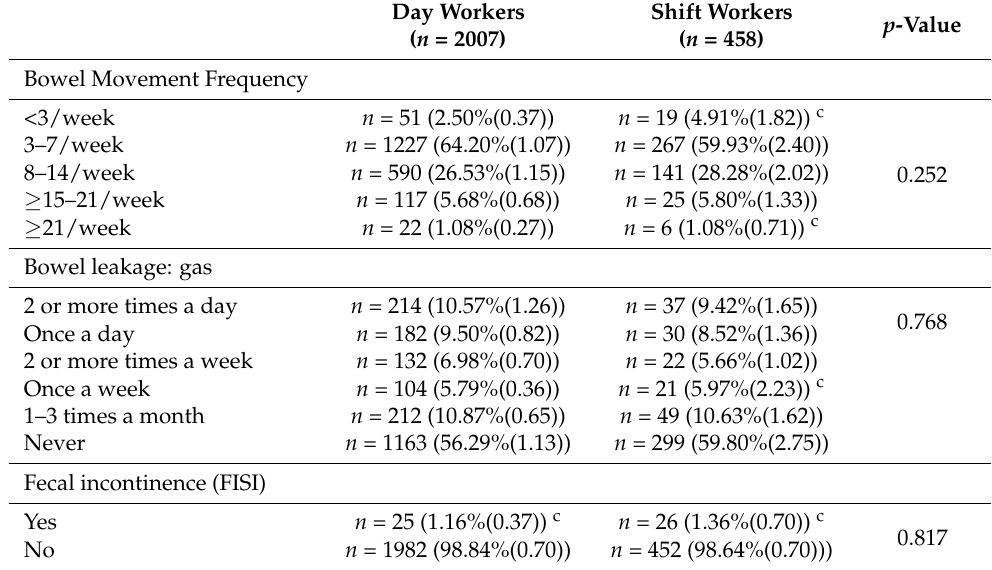
Table 3 legend: Column percentages may not equal 100% due to rounding. The p -value is based on STATA’s design-based Rao–Scott F -test and tests for a potential association between shiftwork status and the respective